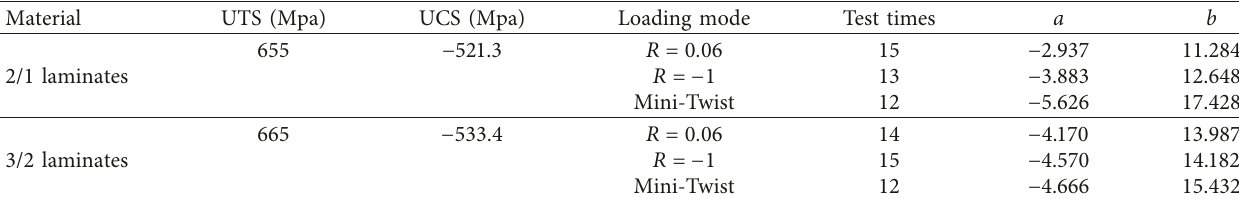
Figure 7: The S-N curve of 2/1 and 3/2 laminates: (a) R � 0 . 06; (b) R � − 1; (c) Mini-Twist loading. Table 2: Static strength data, fatigue test times, and S-N curve parameters for each